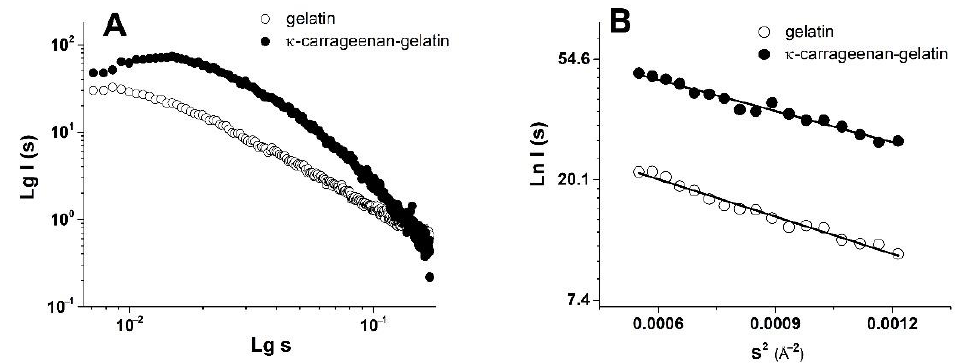
Figure 2. Experimental SAXS data for gelatin and κ -carrageenan–gelatin gel ( A ) and linear approximation of the Guinier plot ( B ) after background substruction.